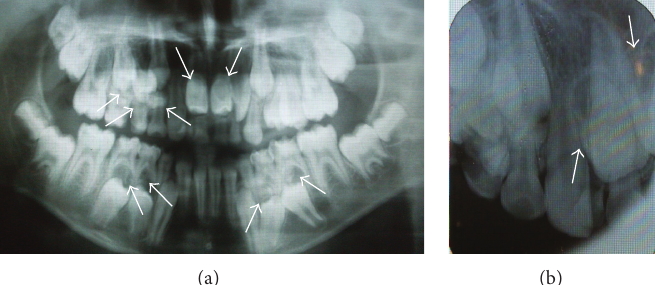
Figure 2: Preoperative radiographs showing multiple supernumerary teeth. (a) The arrows show 9 supernumerary teeth in both jaws. (b) The arrows show 2 supernumerary teeth in the upper anterior